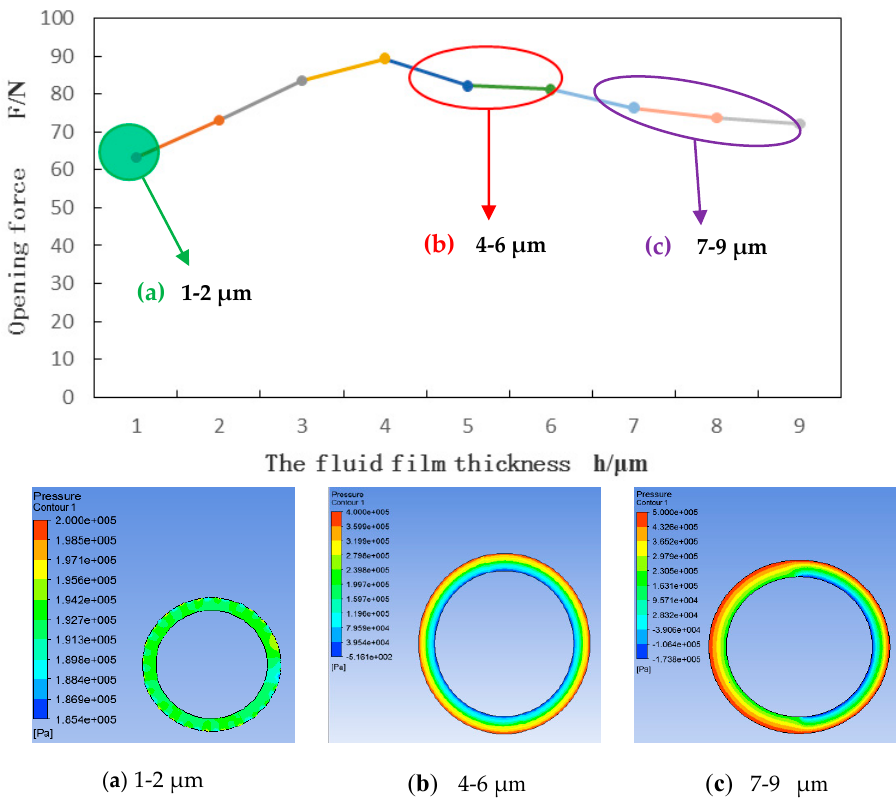
Figure 16. Opening force under different fluid film.